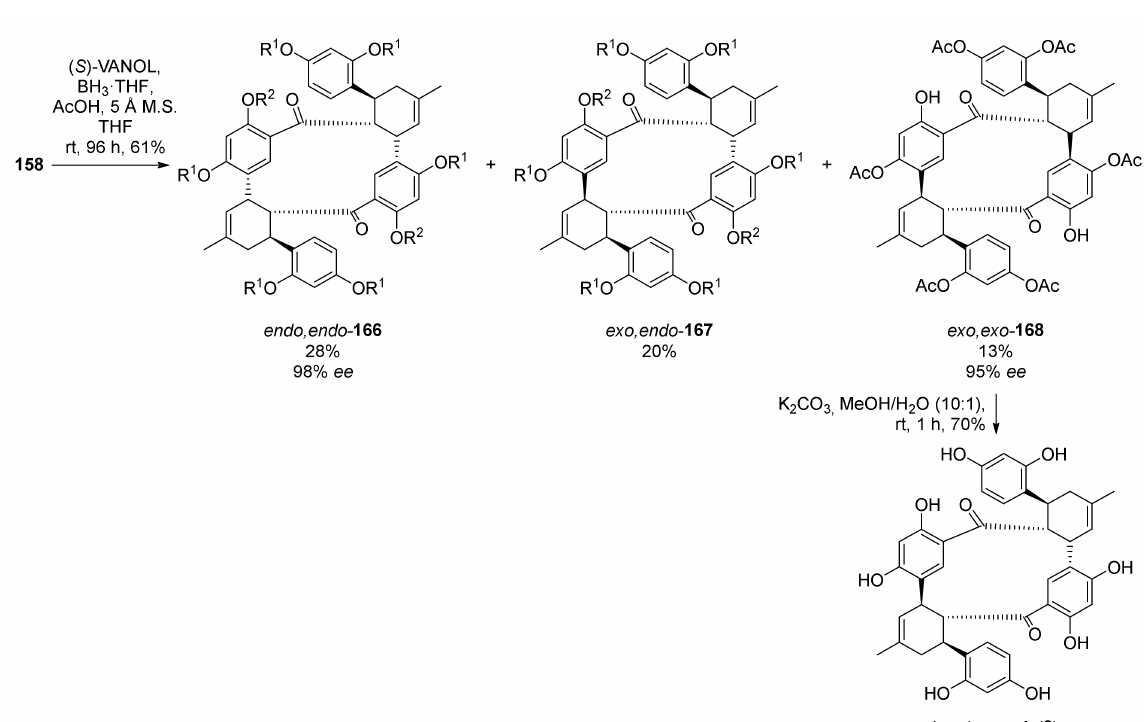
Figure 55. Enantioselective intramolecular Diels–Alder cycloaddition towards brosimone A. As previously said, the synthesis of kuwanons I and J proceeded from the ortho - prenylated dienophile 162 , prepared via 1,3-shift of the prenyl chain catalysed by Montmo- rillonite K10, which allowed the target regioisomer to be obtained in 37% yield (Figure 53). Reaction conditions have been optimized for the preparation of diene 160 starting from dienophile 156 via subsequent Schenck ene reaction/reduction and dehydration. It has been found that a visible-light-mediated regioselective Schenck ene reaction using [Ru(bpy) 3 Cl 2 · 6H 2 O] and MeOH was the best combination to achieve the tertiary alcohol in 55% yield (Figure 56). Following dehydration reaction in the presence of SOCl 2 /DBU provided diene 160 resulted in a 75%